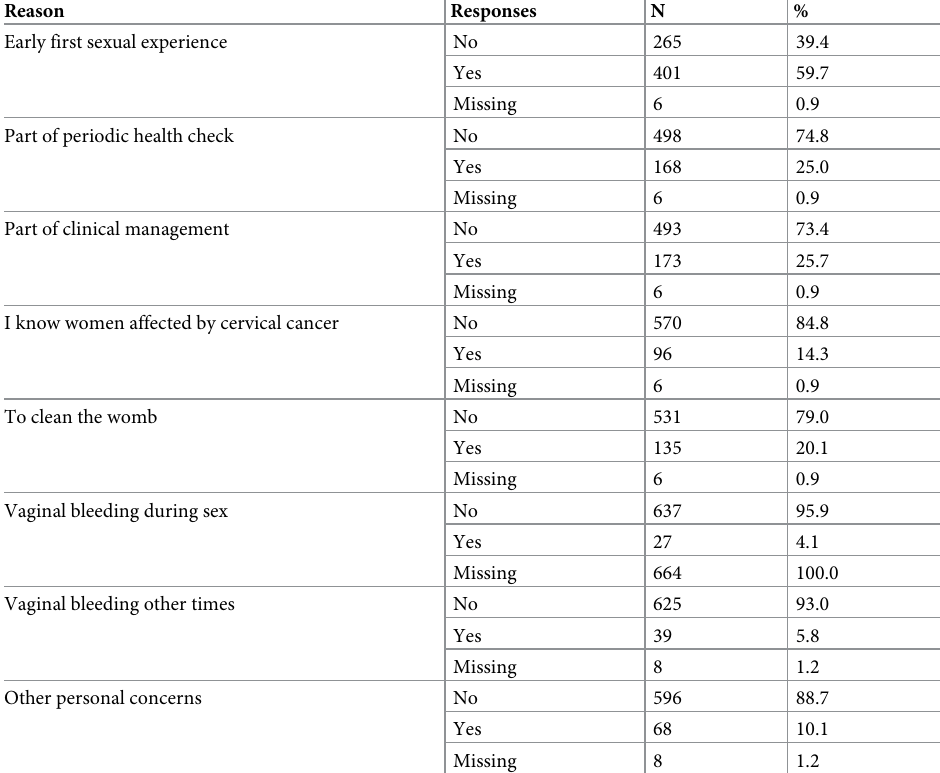
Table 4. Reasons for taking the cervical cancer screening test among black women in the past 10 years attending Pap smears in primary health care clinics in Gauteng Province, South Africa (N = 672).